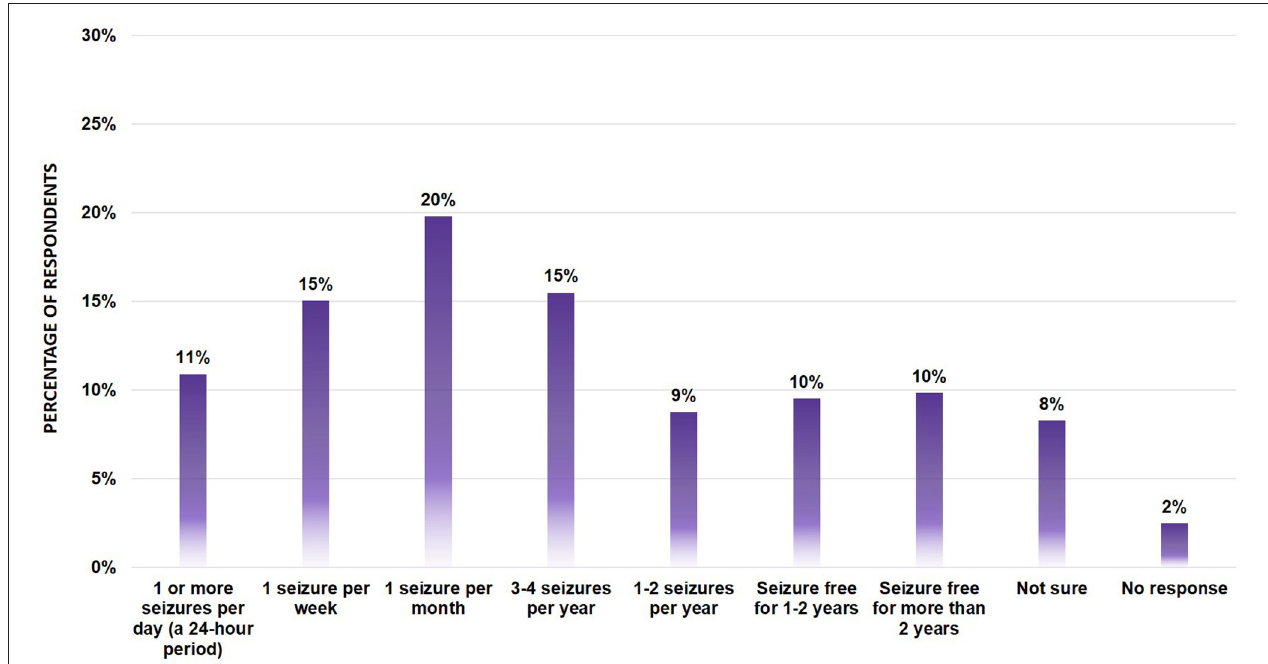
FIGURE 1 | Seizure Frequency of survey participants ( n = 652). Bar graph showing the percentage of respondents across the various seizure types. No significant differences were found between segments using the Mann-Whitney U